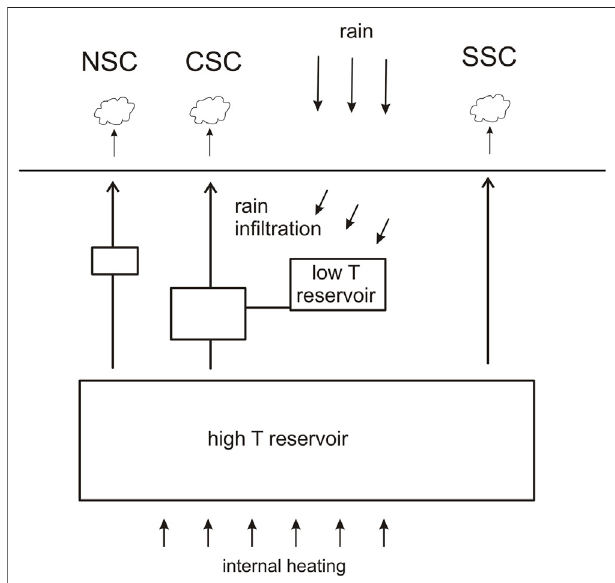
FIGURE10| Conceptualmodelofthehydrothermalsystembeneaththe South Crater area (see text for details.).